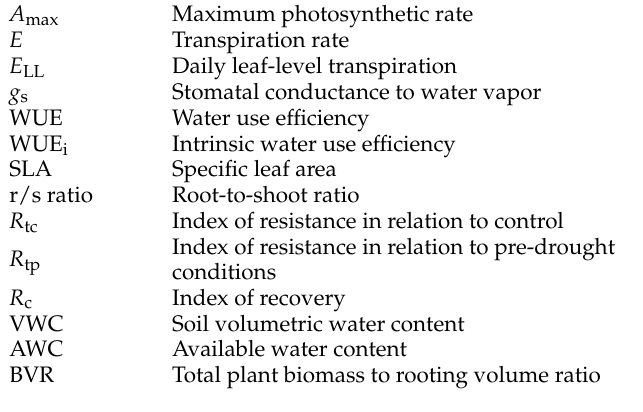
Figure S1: Mean values of soil volumetric water content (VWC) at different points in time of the experiment for plants of the control, the drying/rewetting, and the dry treatment group, Table S1: Means and standard deviation ( ± SD) of shoot length, root length, fresh plant mass, and plant age at the beginning of the experiment, Table S2: Means and standard deviation ( ± SD) of specific leaf area (SLA), and relative water content of the leaves of the control, drying/rewetting (d/rw), and dry treatment groups at the end of the experiment, Table S3: Rates for shoot dieback and leaf senescence in seedlings of the drying/rewetting (d/rw), and dry treatments at the end of the experiment; no leaf senescence and shoot dieback occurred in the controls, Table S4: Means and standard deviation ( ± SD) of the total plant biomass to rooting volume ratio